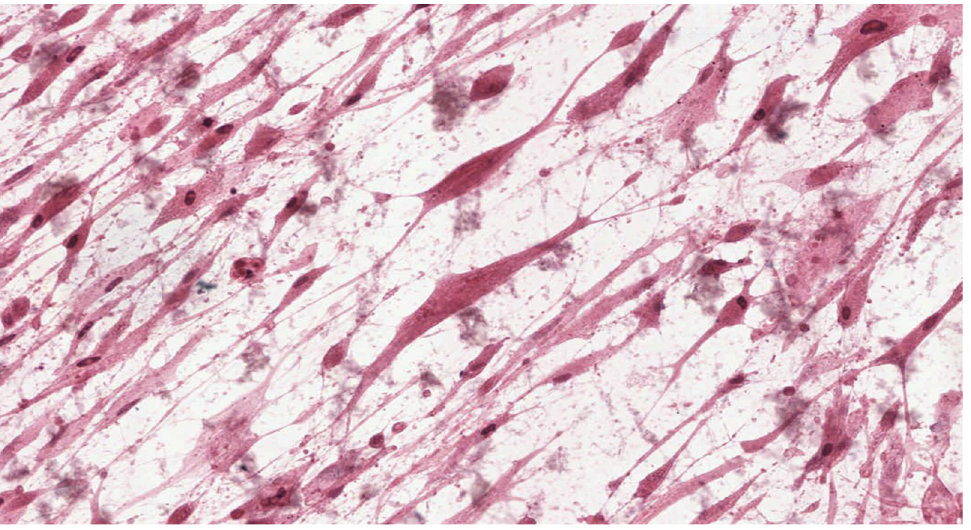
Figure 8. Image of cells cultured on medium with COREGA Extra Strong; 200× magnification.